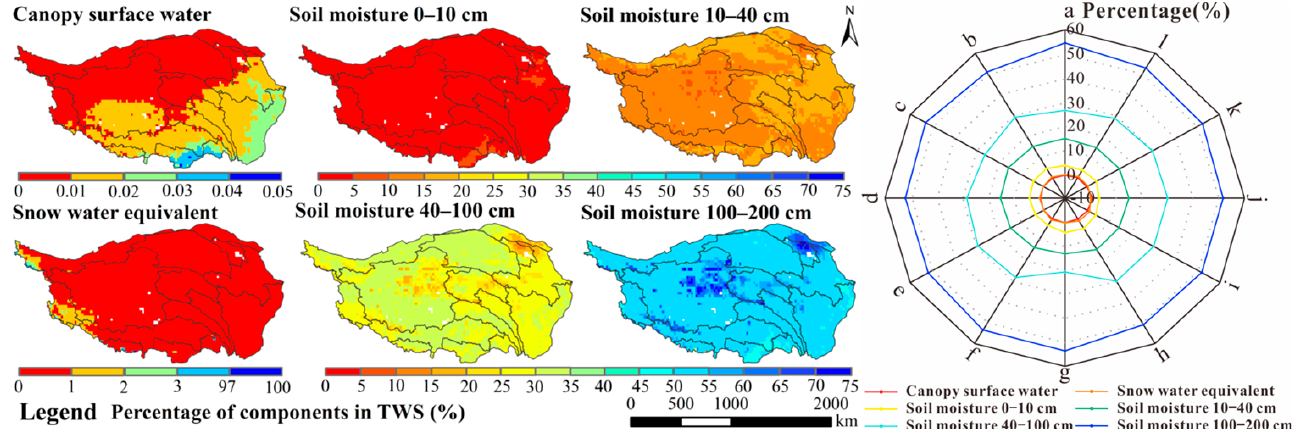
Figure 6. Spatial distributions of the proportions of the terrestrial water storage components over the Tibetan Plateau.